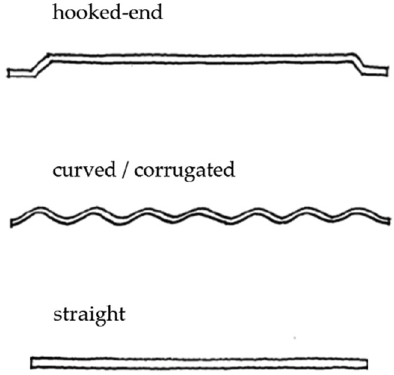
Figure 1: Types of most popular steel fi bers used for reinforcement of